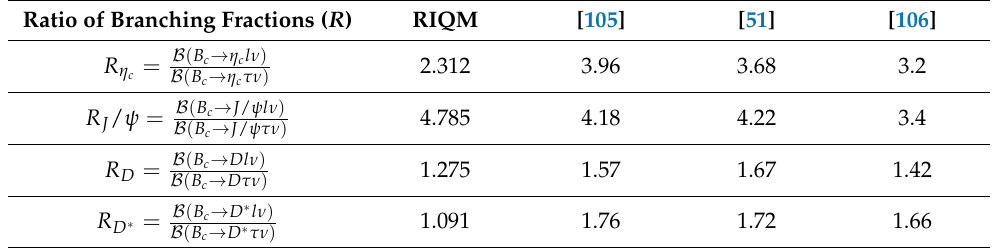
Table 2. Results of ratios of branching fractions for Semileptonic B c -decays in the ground state. Ratio of Branching Fractions ( R ) RIQM [105] [51] [106]